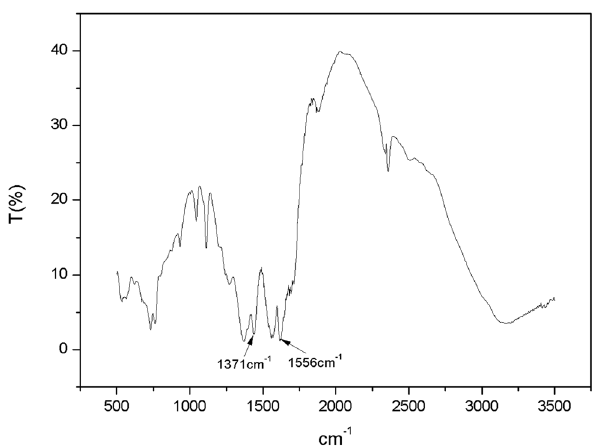
Figure 2: IR of Zn - MOFs.